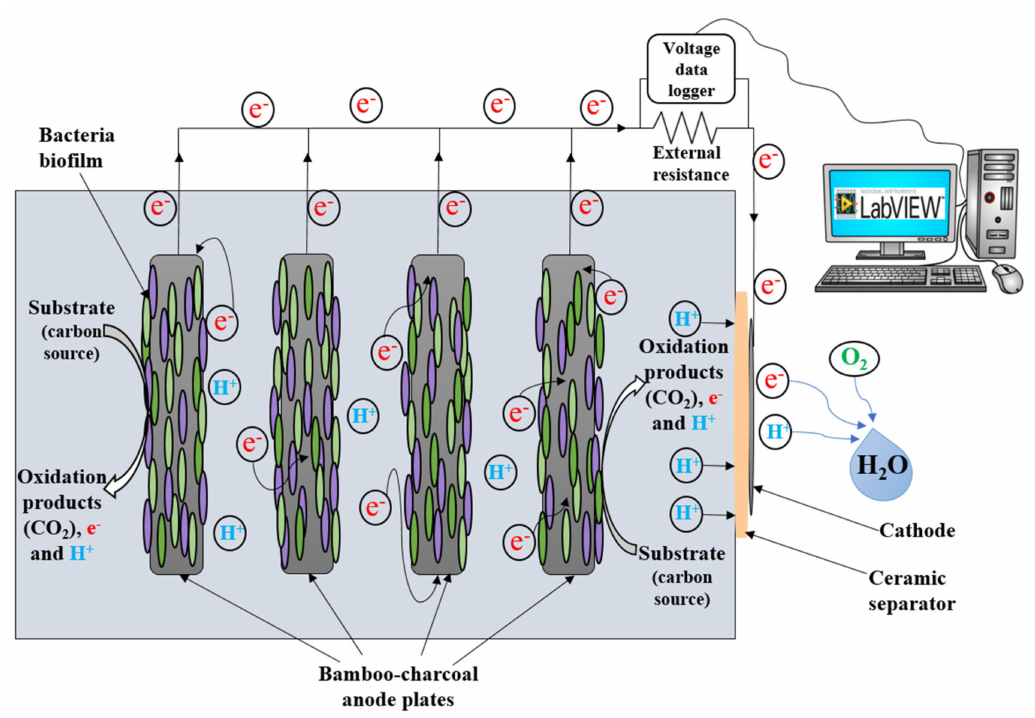
Figure 2. Representation of a single-chamber MFC with multiple anode